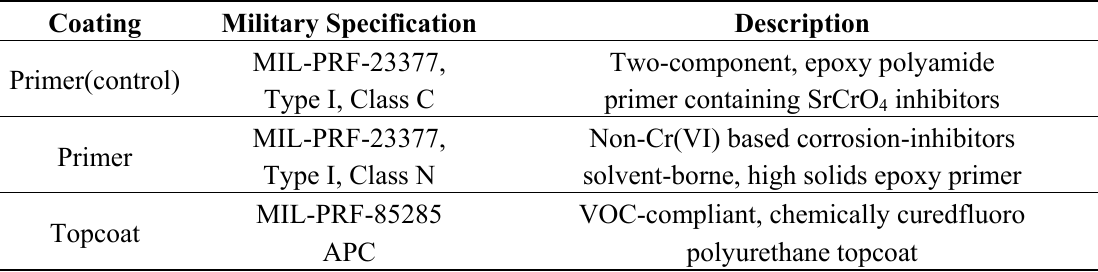
Table 6. Air Force primers and topcoat used for laboratory and field